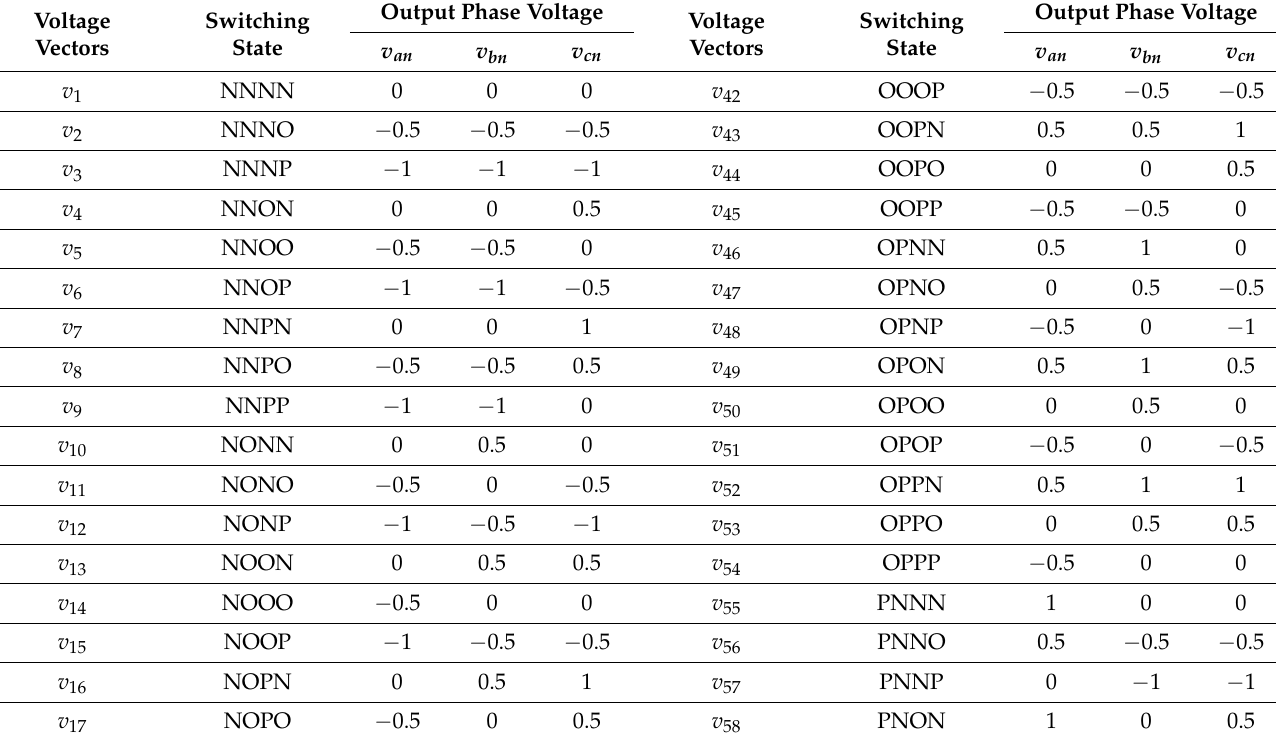
Table 4. Input voltage according to the switching state of the three-level four-leg